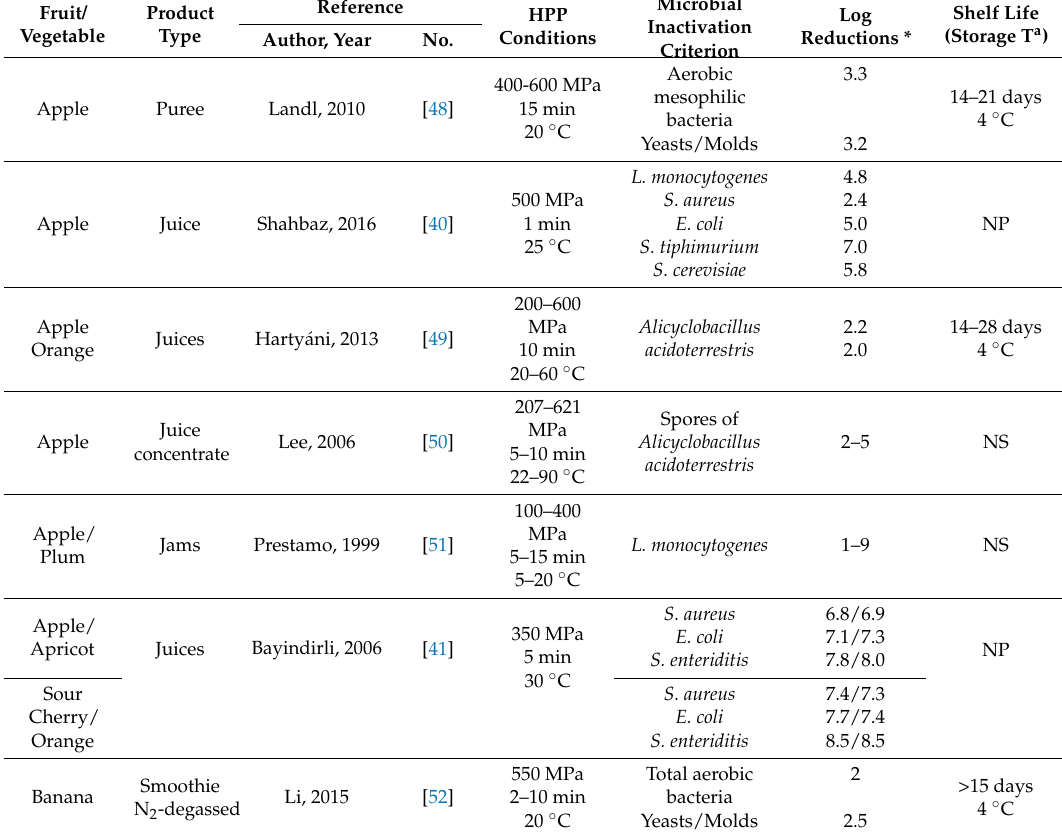
Table 3. Microbial safety (expressed in log reductions) of vegetative forms (bacteria, yeast and molds) and shelf life, in fruit/vegetable preparations processed by